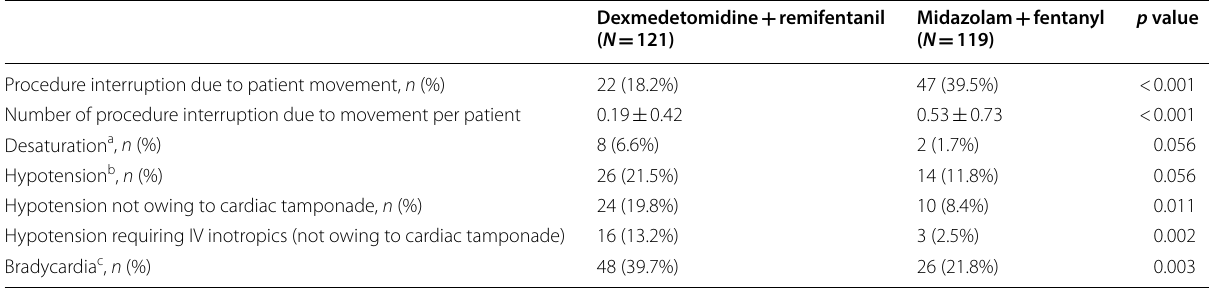
Categorical variables are presented as frequency with percentages (%) and continuous variables are presented as mean significant a Event for peripheral oxygen saturation < 90%